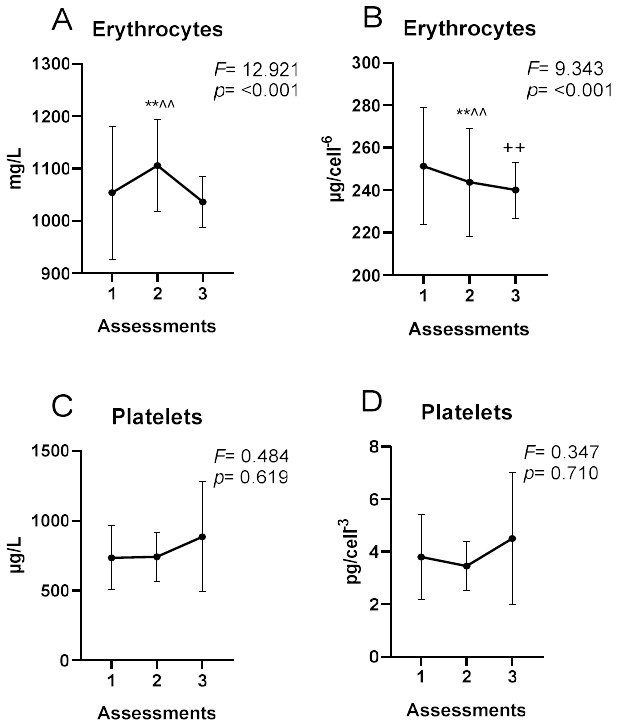
Figure 2. Intracellular concentrations of Fe. ( A ) Absolute erythrocyte concentrations; ( B ) concentra- tions relative to the number of erythrocytes; ( C ) absolute platelet concentrations; ( D ) concentrations relative to the number of platelets; ** p < 0.01 assessment 1 vs. assessment 2; ++ p < 0.01 assessment 1 vs. assessment 3; ^^ p < 0.01 assessment 2 vs. assessment 3.